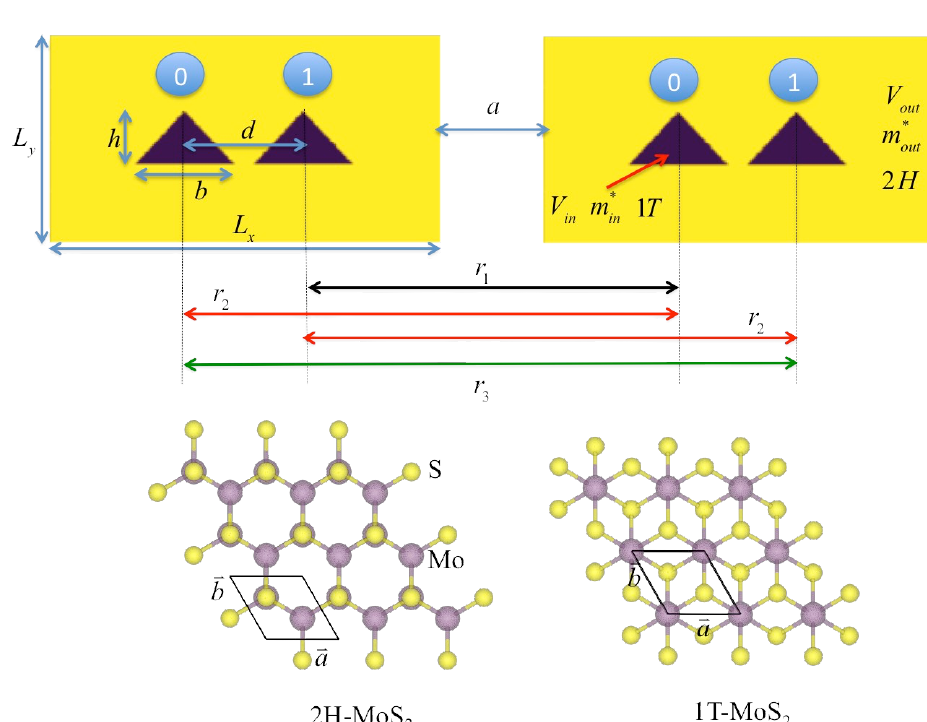
Figure 1. Schematic diagram of 2D two DQDs which different colors representing the different electronic potentials. This is an illustration of MoS 2 in Ref. [21]. Yellow rectangles denote the 2H phase, and violet triangles denote the 1T